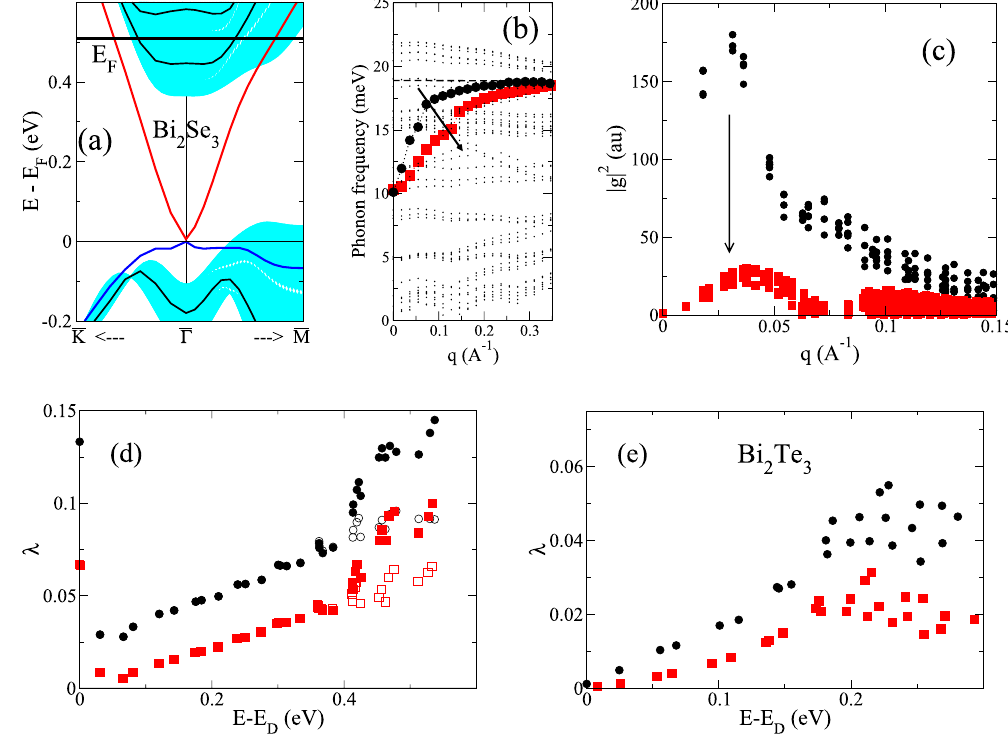
Figure 4. ( a – d ) Changes of EPI under doping for Bi 2 Se 3 (3QL). ( a ) Bandstructure indicating position of Fermi level. ( b ) Phonon dispersion along the Γ M direction. Large, filled squares highlight the in-plane polar-type branch. The dispersion for low doping (see Fig. 1) is shown by the black circles for comparison. The arrow indicates the enhanced screening effect on this mode. ( c ) Squared electron-phonon matrix elements, | g | 2 , as function of the momentum transfer q . Red squares correspond to heavy doping, black circles to the slightly doped case, respectively. ( d ) Coupling constants for the upper part of the Dirac cone comparing the two dopings (read squares: large doping; black circles: low doping). ( e ) Coupling constants for a 4QL slab of Bi 2 Te 3 comparing undoped (black circles) and the heavily doped case (red